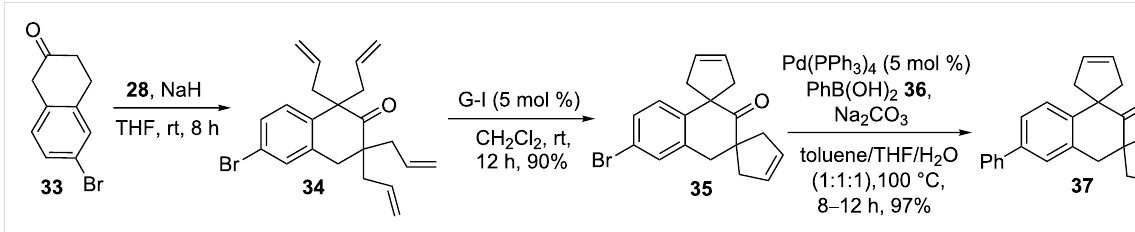
Scheme 5: Synthesis of highly functionalized bis-spirocyclic derivative 37 .